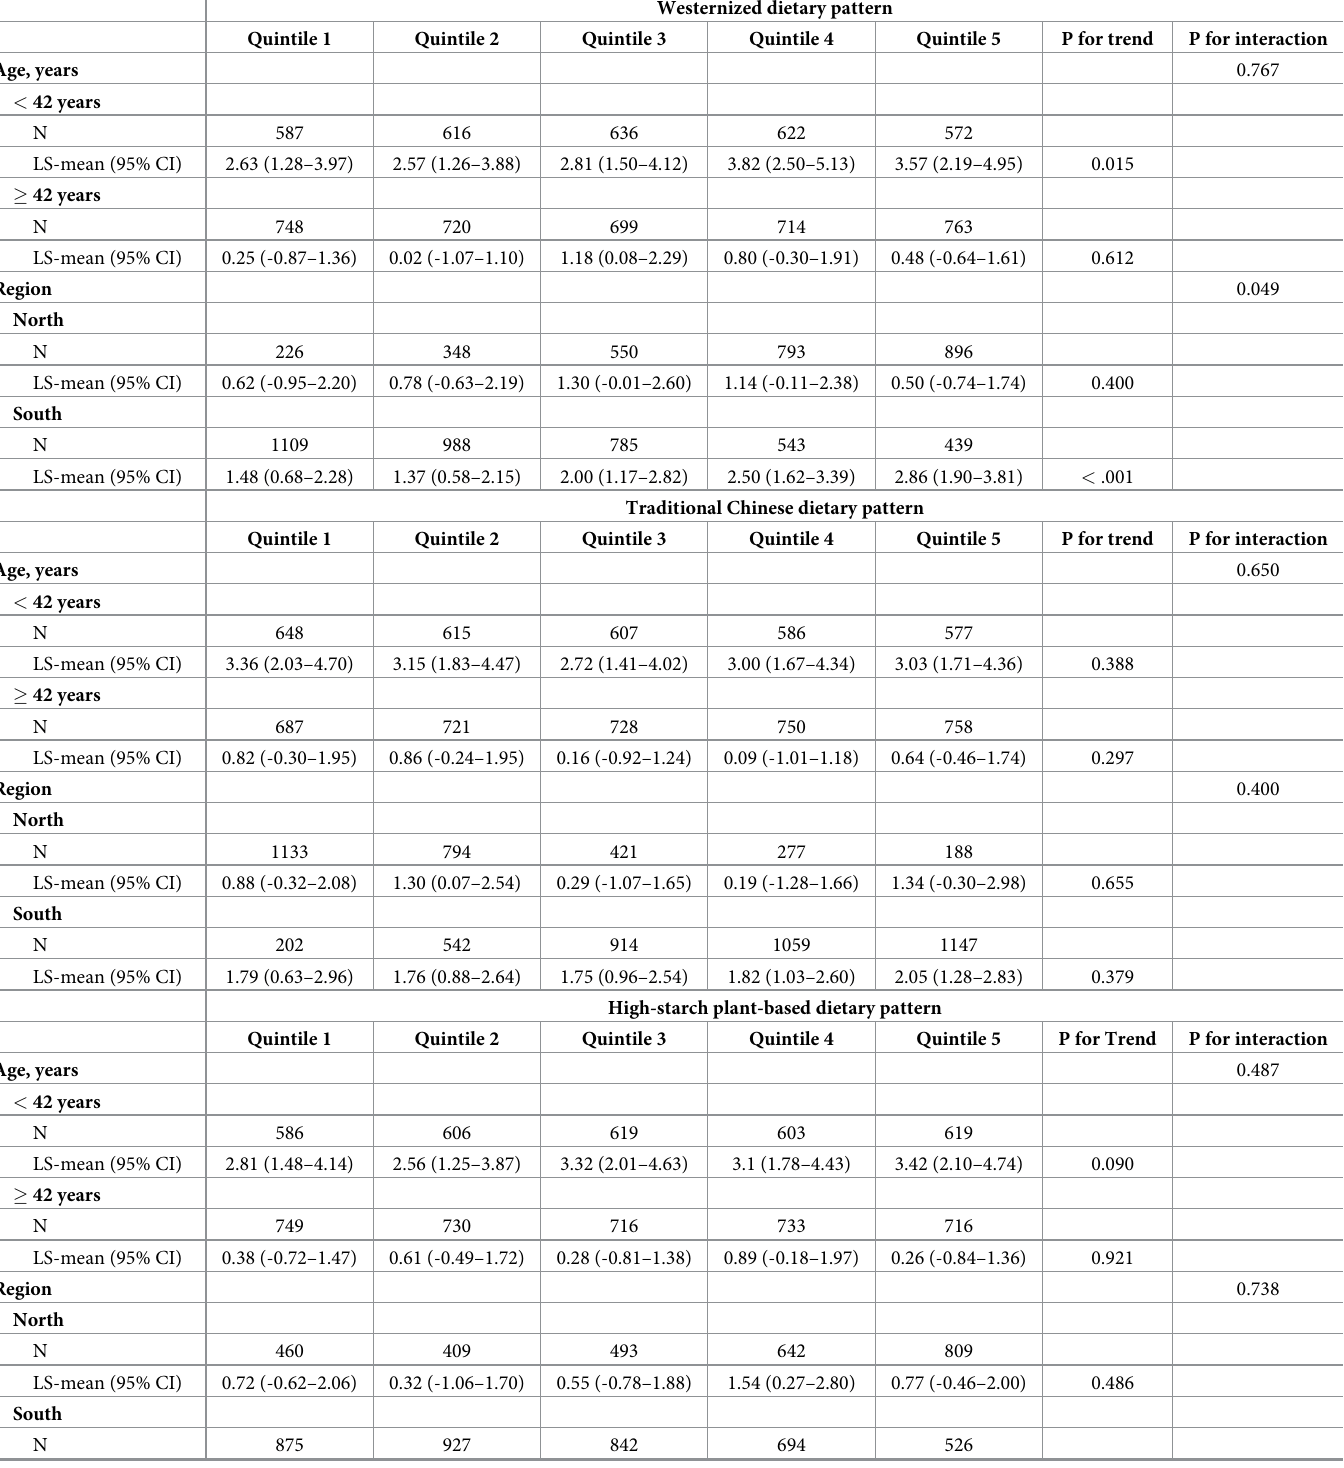
Table 6. Least-squares means a of body weight change (kg/5 years) according to quintiles of dietary patterns by age and region. Westernized dietary pattern Quintile 1 Quintile 2 Quintile 3 Quintile 4 Quintile 5 P for